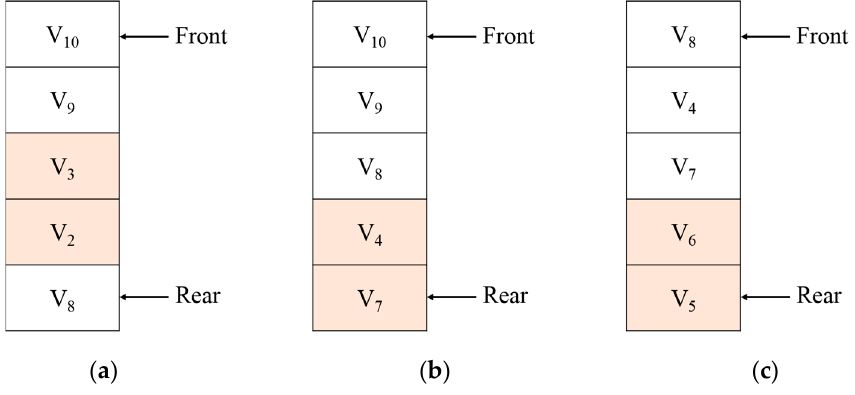
Figure 7. Prefetched cache replacement: ( a ) initial states; ( b ) cache hit; ( c ) cache replacement.